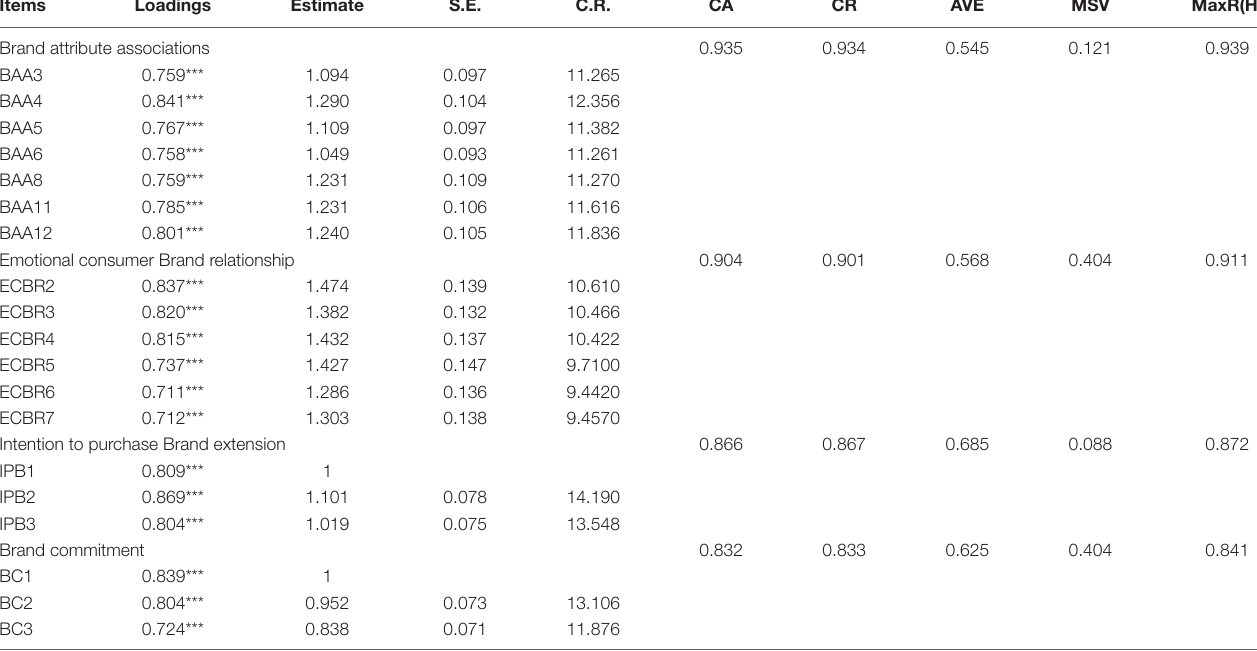
TABLE 2 | Confirmatory factor analysis results.